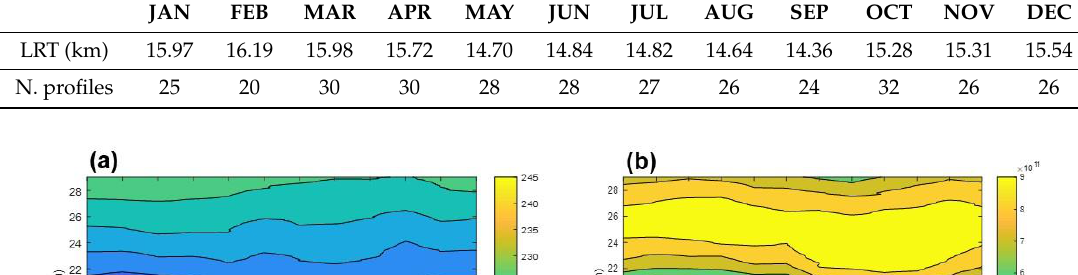
Figure 4. Monthly mean climatological temperature ( a ) and ozone-concentration ( b ) time-height cross-sections as derived from ozonesonde observations at Irene from 1998 to 2017. Cold-point tropopause (CPT) and lapse-rate tropopause (LRT) monthly variations are superimposed on Figure 4a with white dashed and continuous red lines, respectively. Table 1. Monthly mean climatological heights of LRT as derived from balloon-sonde temperature observations at Irene and during the study period (1998–2017), and number of profiles used.